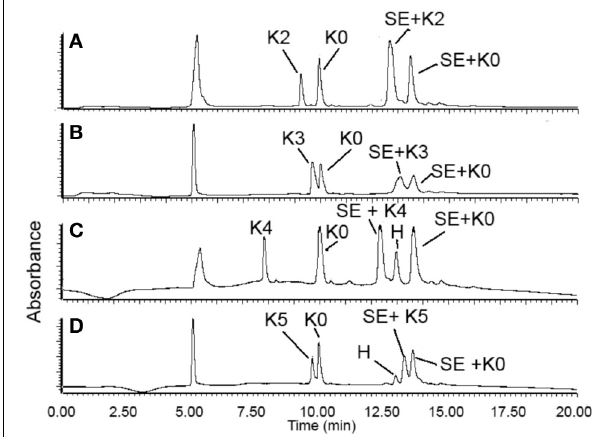
FIGURE 2 | RP-HPLC spectra of STL of the peptide SAL ester with peptides K2–K5. SE = peptide-SAL ester; H = hydrolysis of peptide-SAL ester; SE + K X = ligation product. Ligation time: (A) (1.5 h) and (B–D) (4